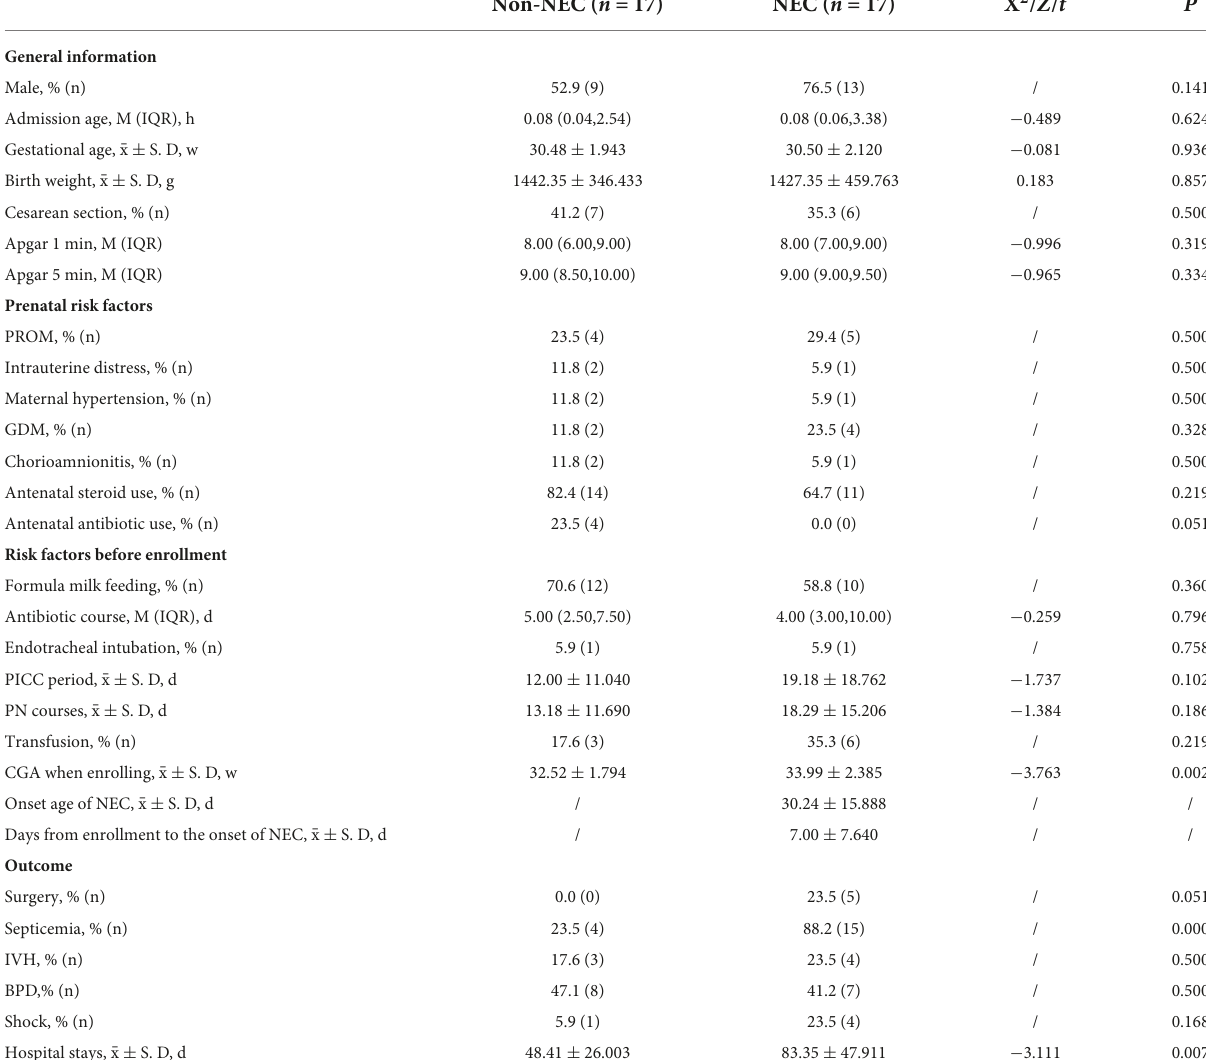
TABLE 1 Clinical features of the infants enrolled in this